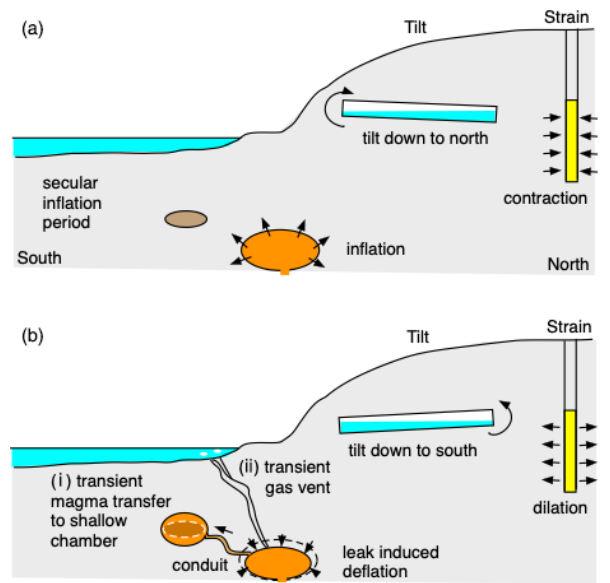
Figure 10. (a) Inferred secular Inflation of deep magma source leading eventually to fracture of the confining rock. (b) Two pos- sible mechanisms for deflation (i) leak to shallower chamber via a hydraulic conduit, or (ii) submarine or subaerial venting of gas. The transient deflation episode in March 2010 is interpreted as pro- cess (i) (Amoruso et al.,